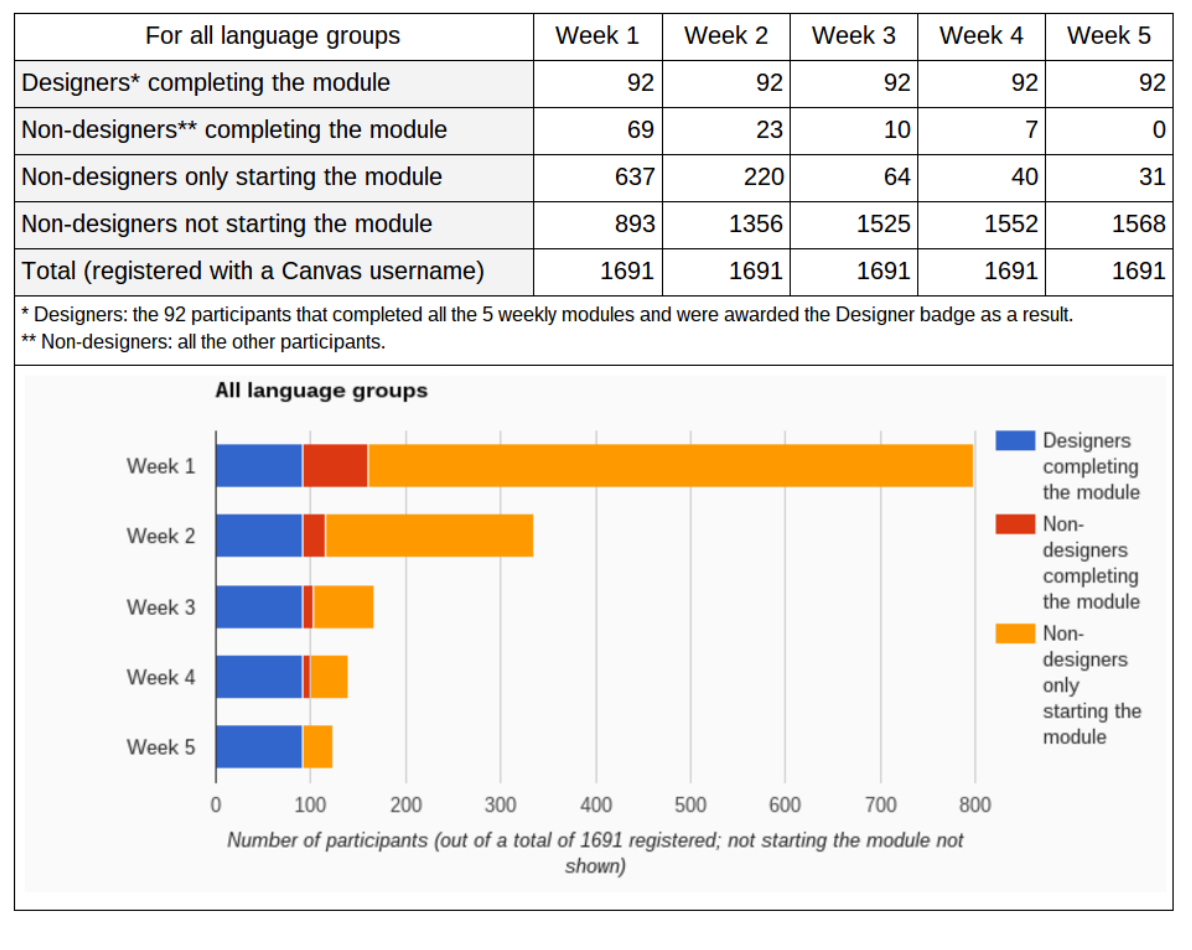
Figure 2 . Participation in weekly modules of activities (all language